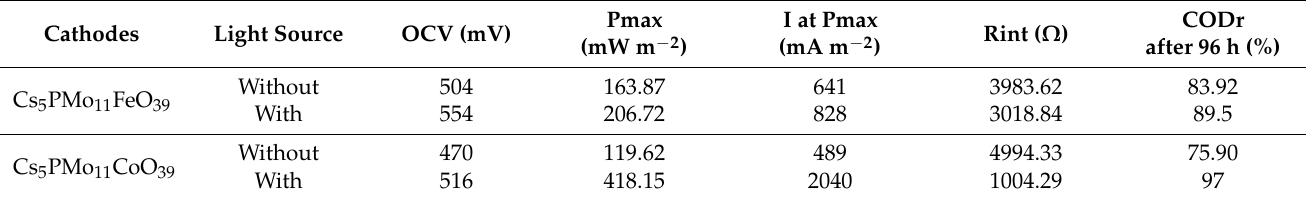
Table 3. Performance of MFCs equipped with polyoxometalate salts cathode in the presence and absence of light.